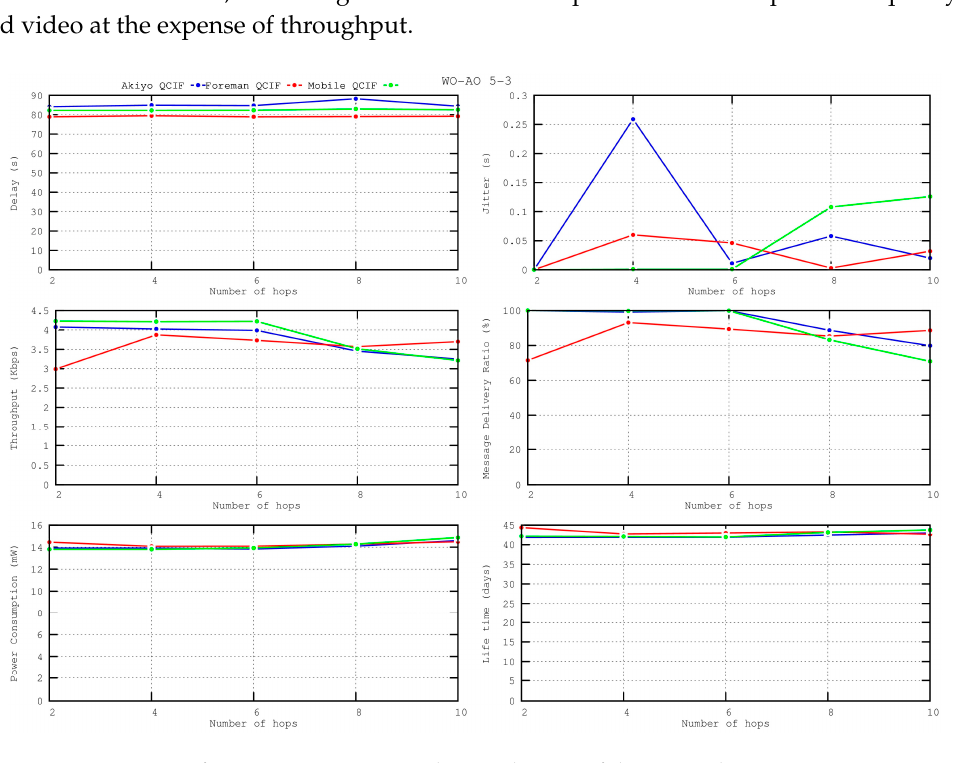
Figure 17. Performance metrics according to the size of the network, WO–AO = 5–3.